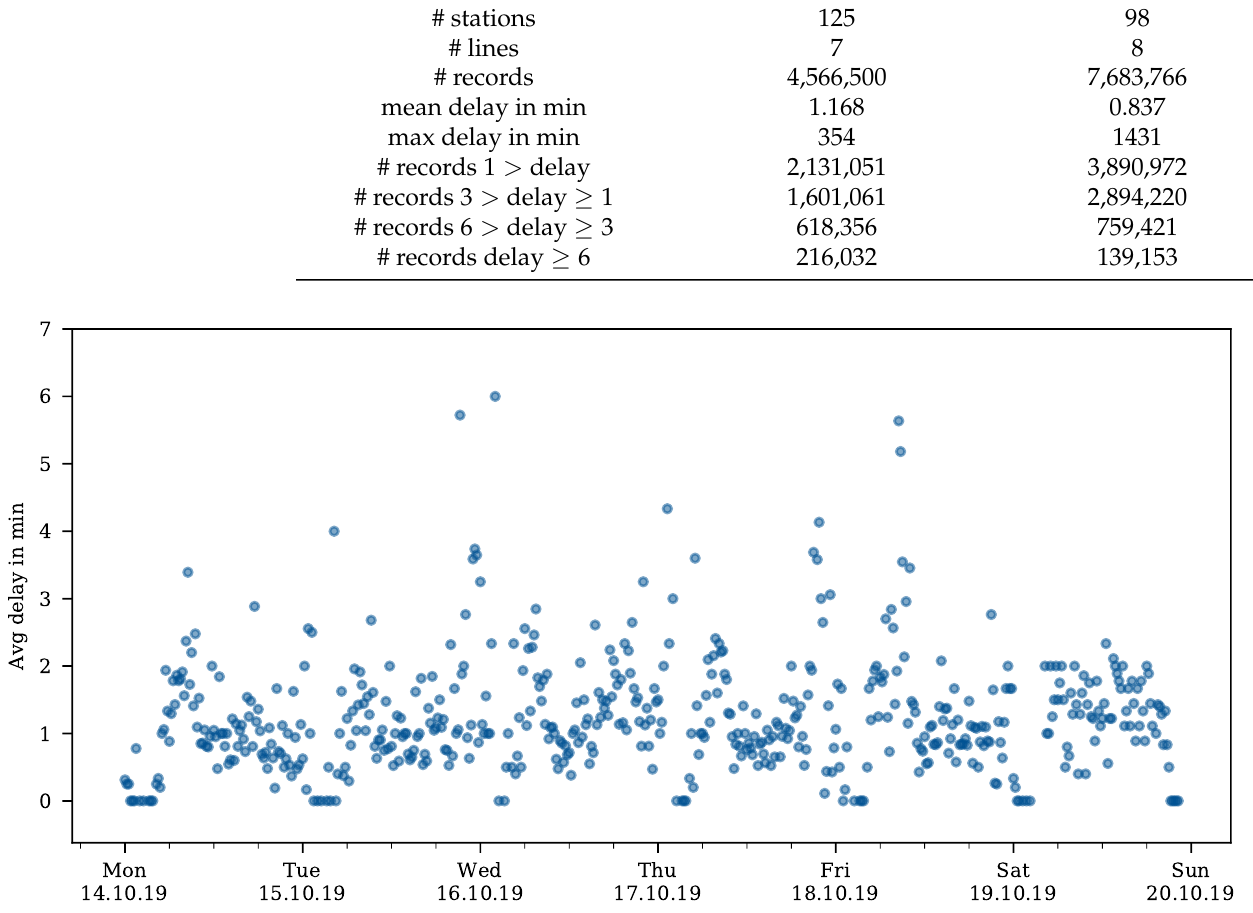
Figure 1. Average of Delays at Marienplatz during Example